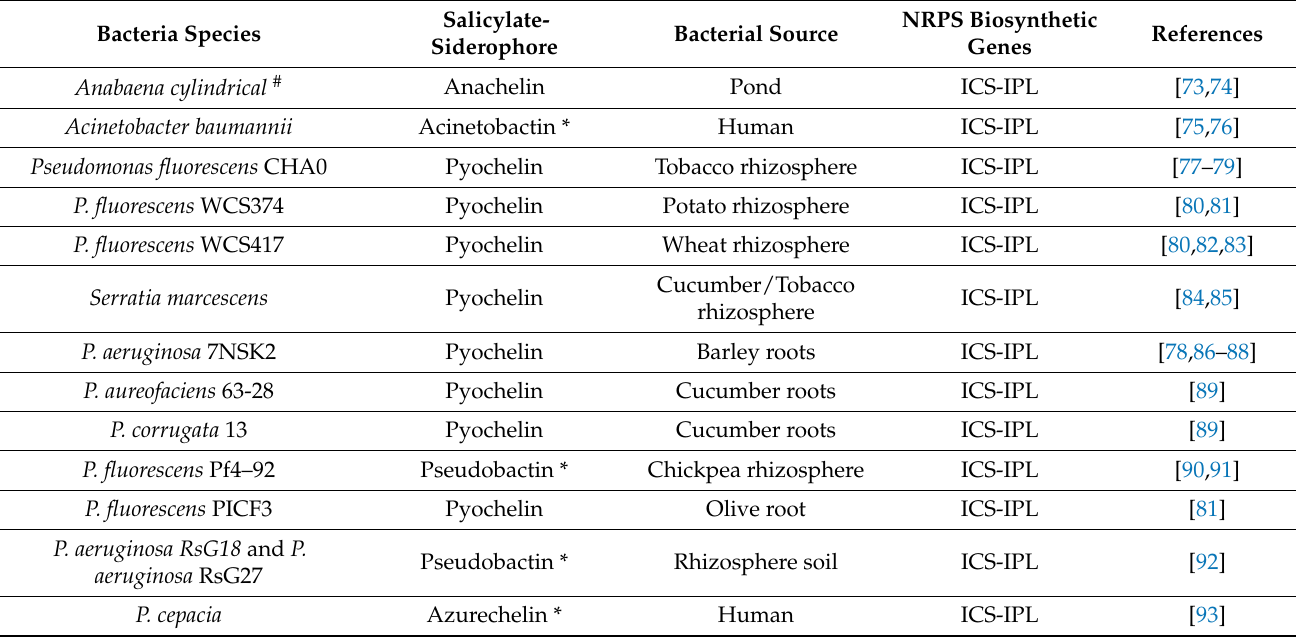
Table 1. Salicylic acid-producing bacteria and their salicylate-derived siderophores. Bacteria